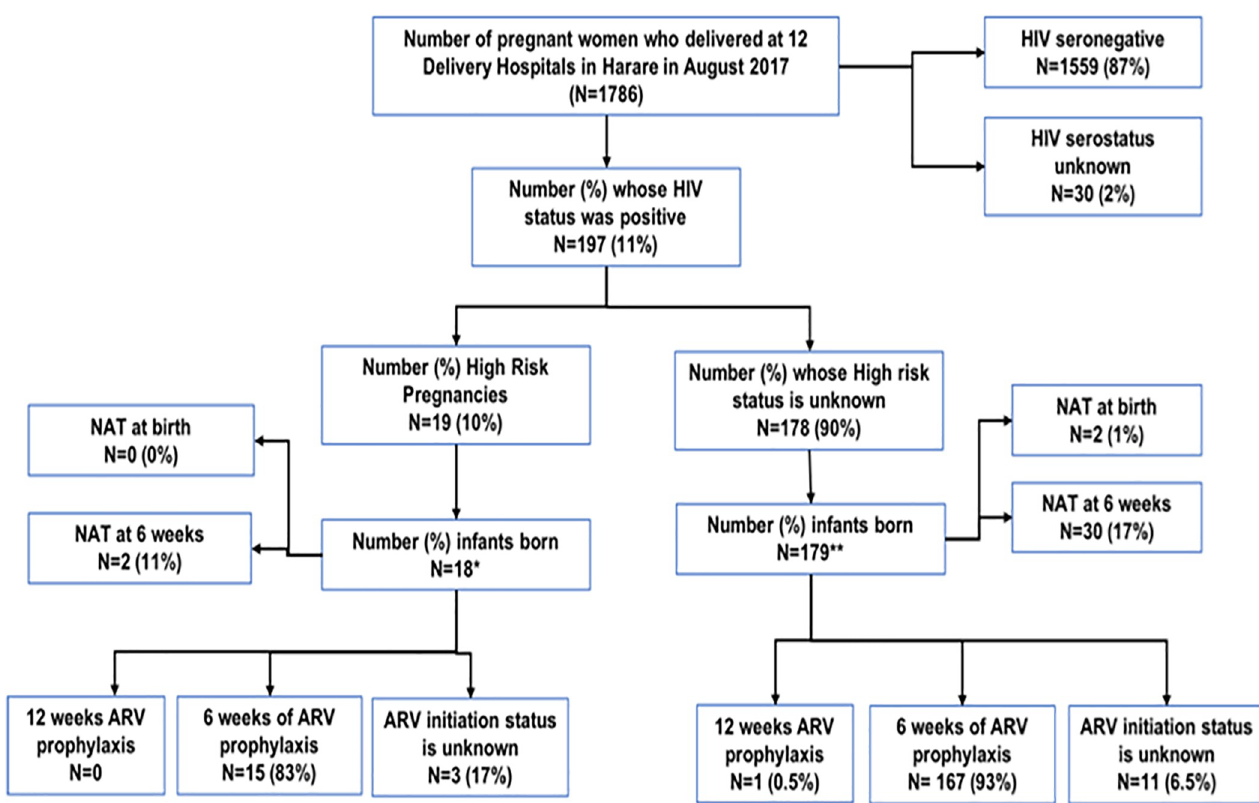
Fig 1. Status of implementing prevention of mother to child transmission services in 12 delivery hospitals, Harare city, August 2017 � 1 still birth; �� 1 twin; NAT = Nucleic acid test; ARV = Anti retroviral; High risk pregnancy were due to late initiation of ARV at the time of delivery.